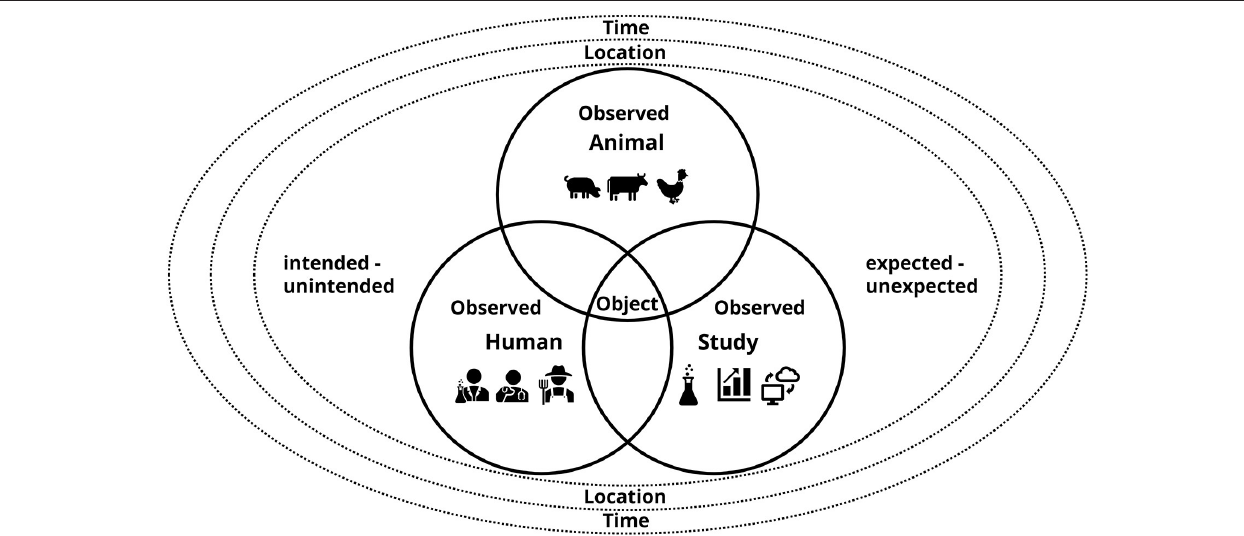
FIGURE 1 | Variables the observer is confronted with in video-based animal studies: the object (i.e., what is seen on the video) and the observed: the study animals, humans in various roles and aspects of the study (e.g., technical equipment) captured on the video. The object and the observed can be on the continua of expected—unexpected and the intended—unintended. All variables are situated within the broader dimensions of location and